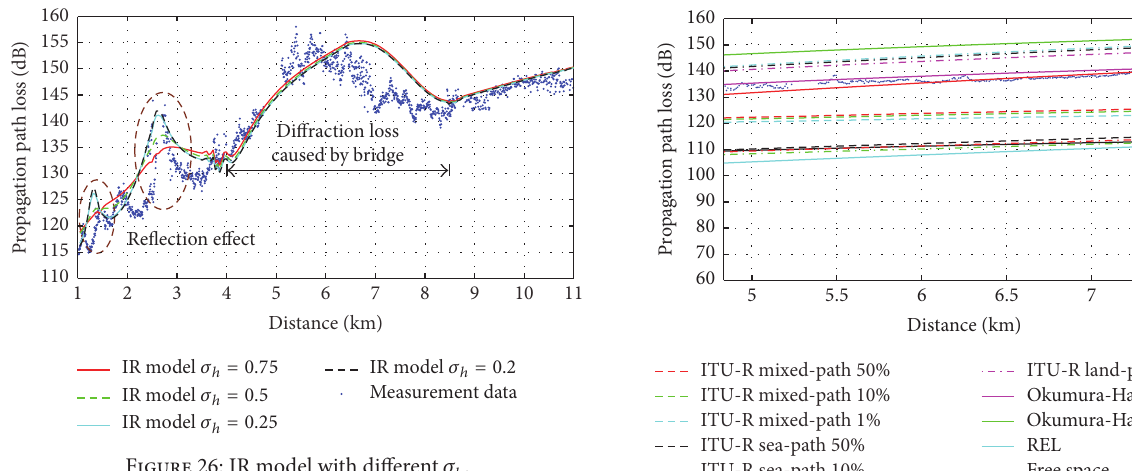
Figure 26: IR model with different 𝜎 ℎ .